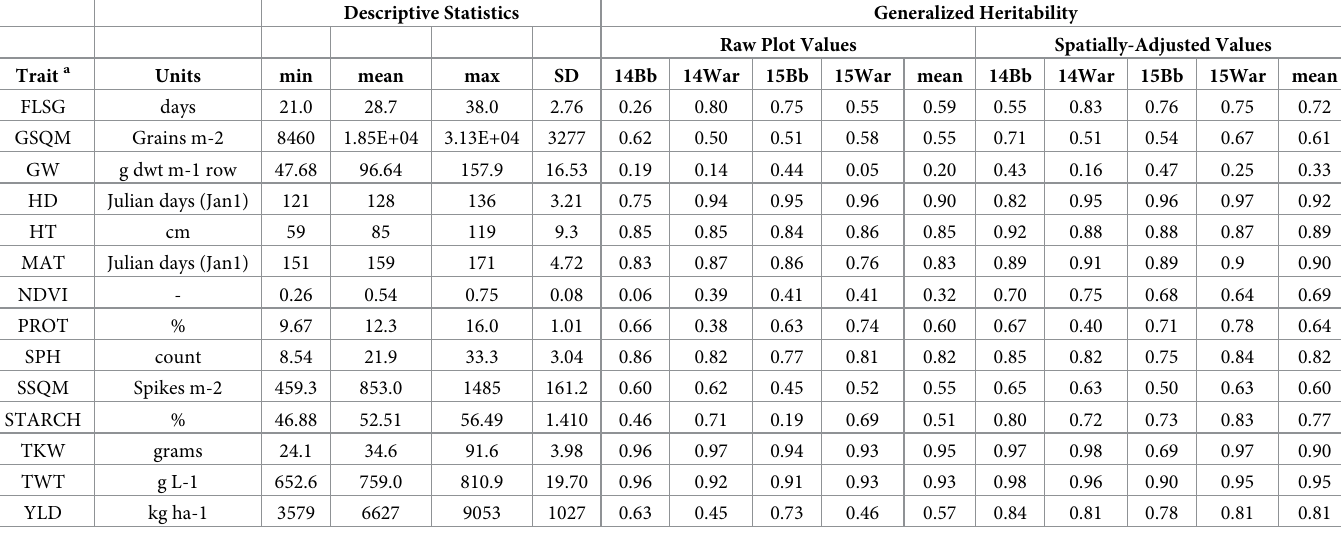
Table 1. Trait descriptive statistics and generalized heritability estimates calculated using raw plot values and spatially-adjusted values. Descriptive Statistics